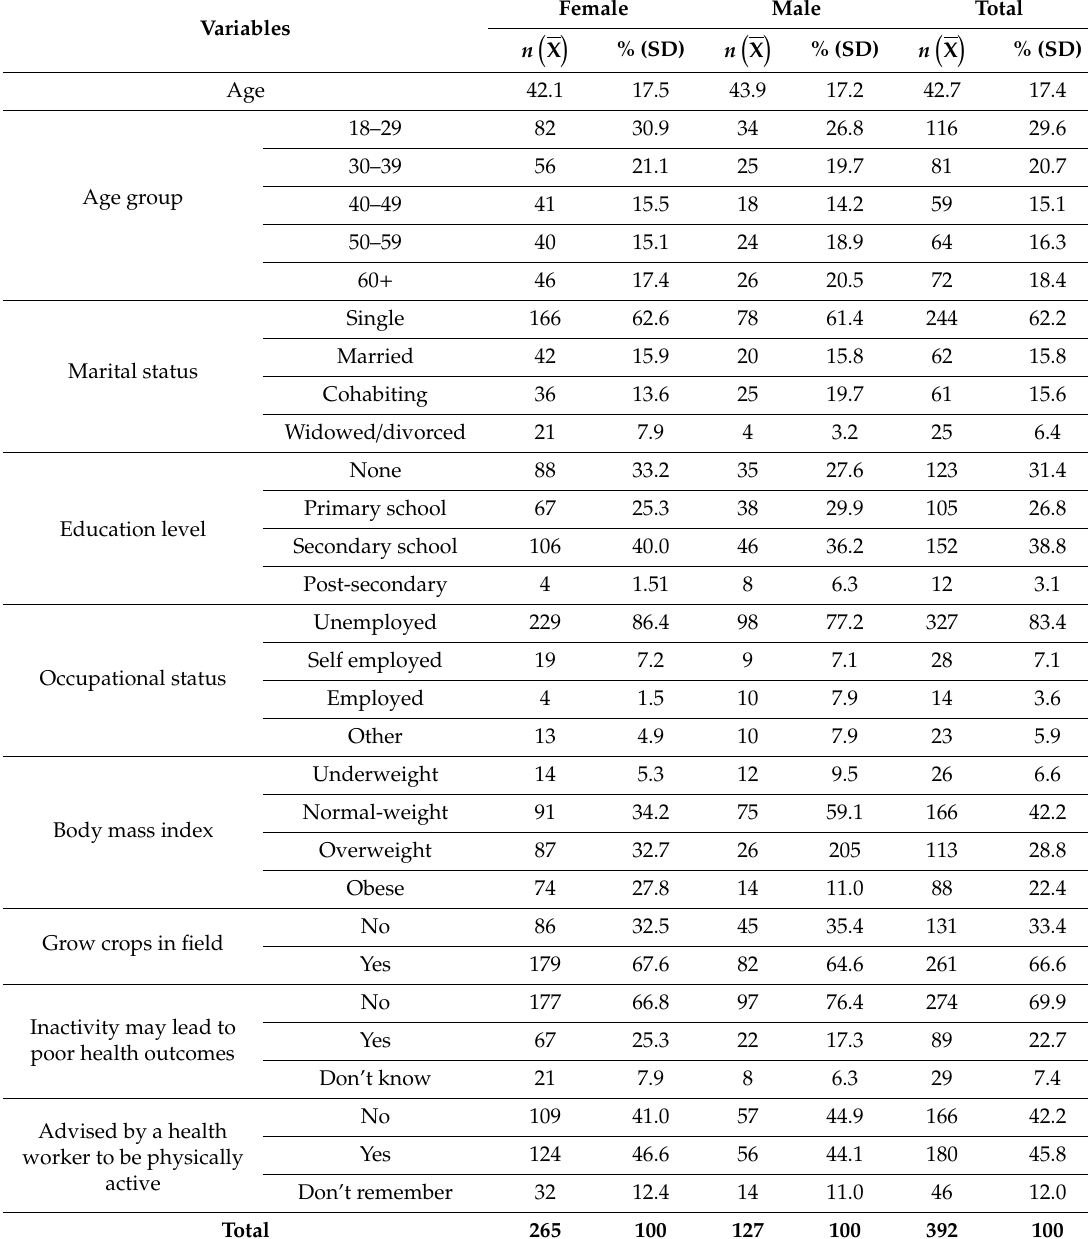
Table 1. Demographic characteristics of the